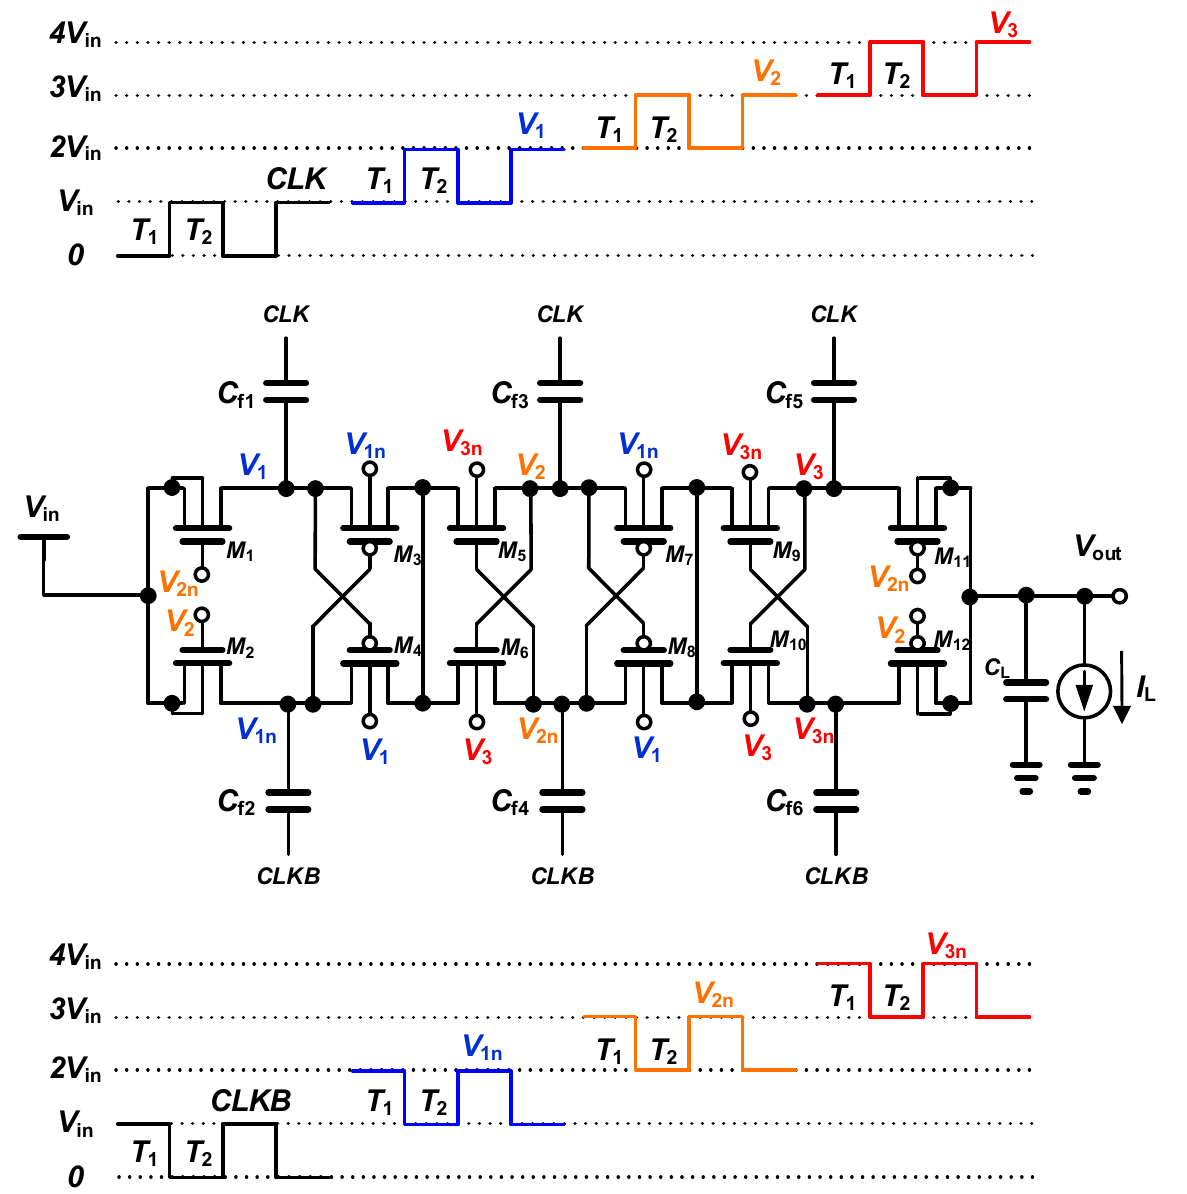
Figure 4. Schematic of the proposed three-stage charge pump using gate bias boosting and dynamic body biasing techniques.